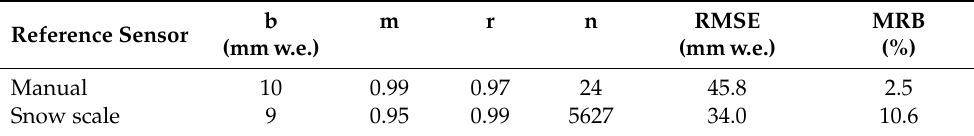
Table 1. Regression coefficients for the comparison of the GNSS-derived SWE with each reference sensor’s data for 2016/17; b and m are the offset and slope of the linear regression fit, and n is the number of